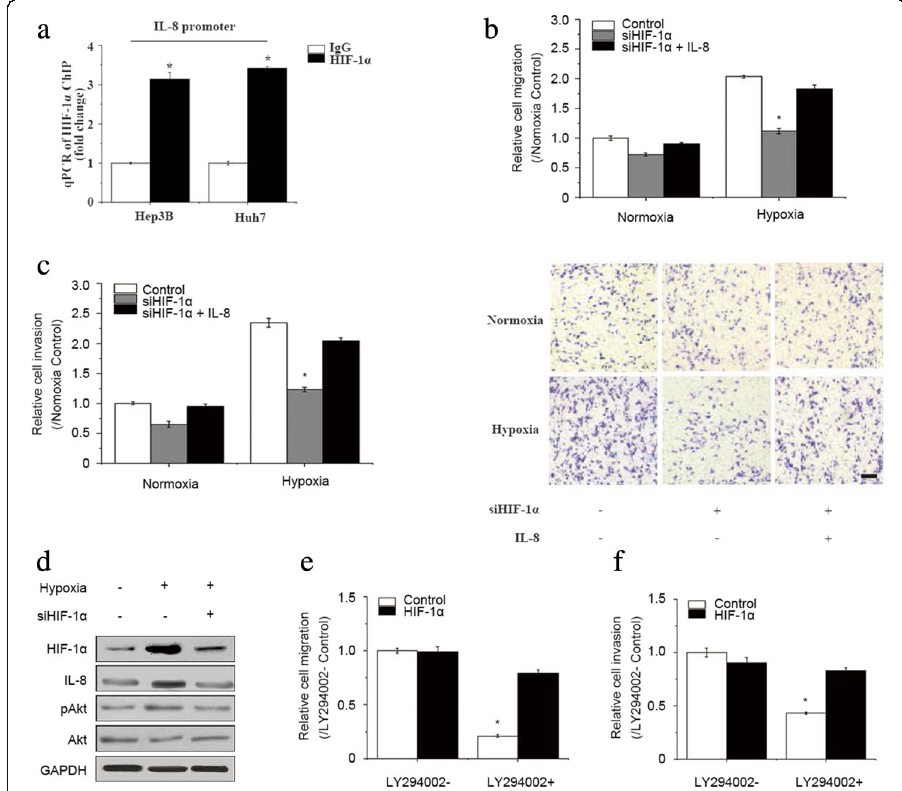
Fig. 2 Exogenous IL-8 restored the migration and invasion that had been attenuated by Akt pathway inhibition . a HIF-1 α antibody was used for ChIP, followed by quantitative PCR with specific primer pairs for the IL-8 promoter ( n = 3; * p < 0.05) in two HCC cell lines under hypoxia. b Relative Hep3B cell migration aftersiHIF-1 α treatment and IL-8 addback treatment under normoxia and hypoxia. The numbers of migrated cells from 5 independent experiments were analyzed. Scale bar: 200 μ m (bottom panel) c Relative Hep3B cell invasion aftersiHIF-1 α treatment and IL-8 addback treatment under normoxia and hypoxia. d Western blot assay of HIF-1 α , IL-8, pAkt and the Akt response to siHIF-1 α treatment. GAPDH was used as the loading control. e Relative Hep3B cell migration showed a decrease when cells overexpressing HIF-1 α were treated with LY294002. f – Relative Hep3B cell invasion showed a decrease when cells overexpressing HIF-1 α were treated with LY294002. All results represent three independent experiments. LY294002-: treated without LY294002; LY294002+: treated with